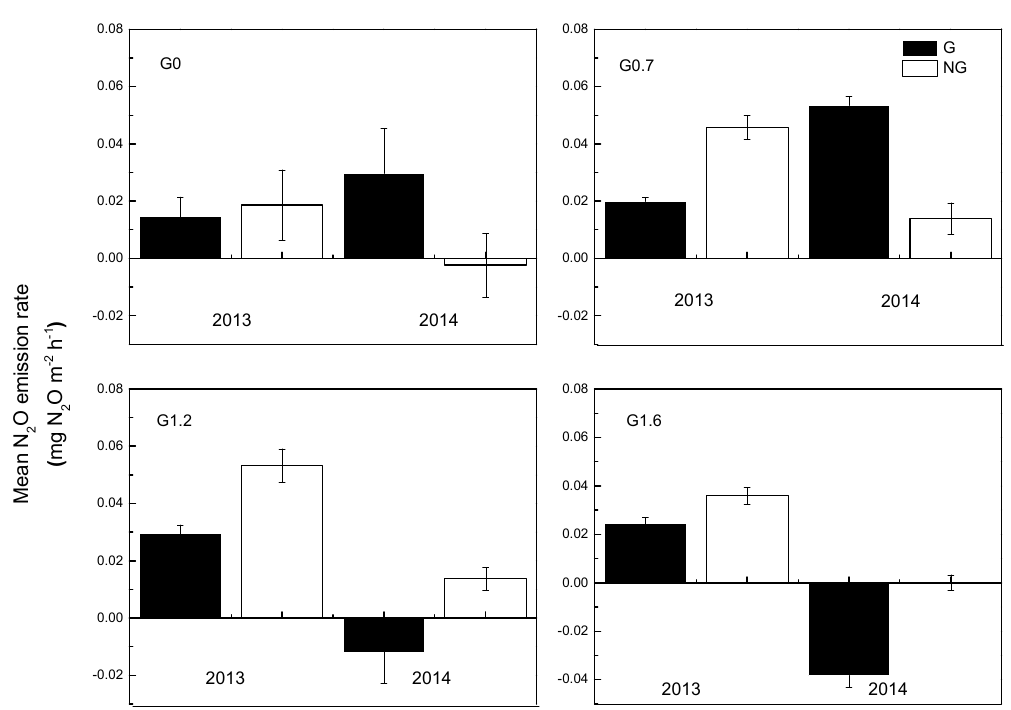
Figure 4. Mean of soil N 2 O emission rates in growing season and non-growing season between 2013 and 2014 under different grazing intensities. Bars represent the means of replicate plots ( ± SE). Letters a and b mean significant differences ( p 215 < 0.05). 216